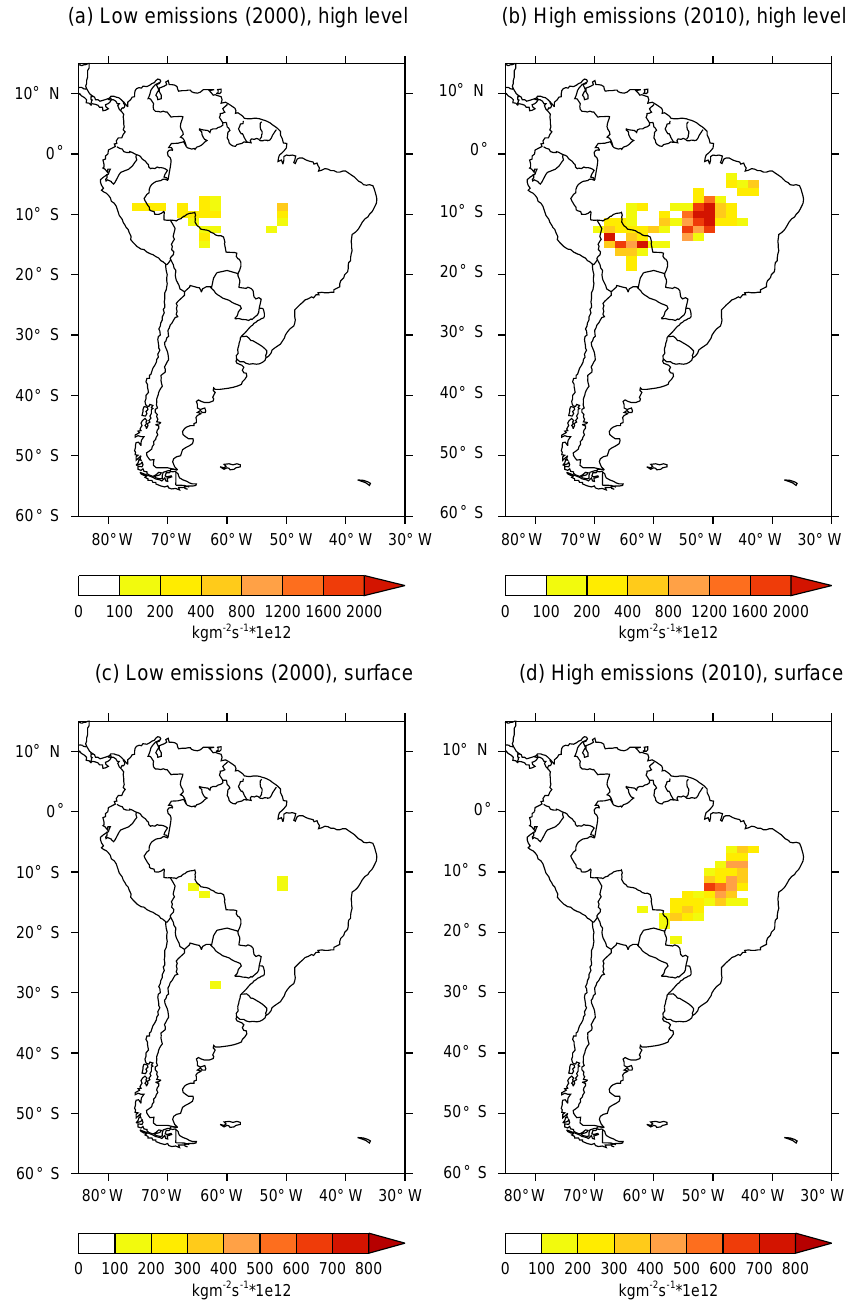
Figure 2. BBA September fire emissions for the low ( a, c , 2000) and high ( b, d , 2010) emission experiments as applied in CLASSIC, from the GFED3.1 dataset. Panels (a) and (b) show high-level BBA emissions, (c) and (d) show surface emissions. Note the different scales between upper and lower